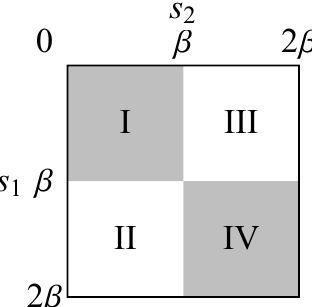
Figure 3. The domain of the bilocal Green’s function ˆ G ( s 1 , s 2 ) . P ( s 1 , s 2 ) is nonzero in the shaded regions I and IV. According to our matrix notation, ˆ G 11 ( s 1 , s 2 ) = G 11 ( s 1 , s 2 ) denotes the Green’s function in region I, ˆ G 21 ( s 1 , s 2 ) = iG 21 (2 β − s 1 , s 2 ) denotes the Green’s function in region II, ˆ G 12 ( s 1 , s 2 ) = iG 12 ( s 1 , 2 β − s 2 ) denotes the Green’s function in region III, and ˆ G 22 ( s 1 , s 2 )